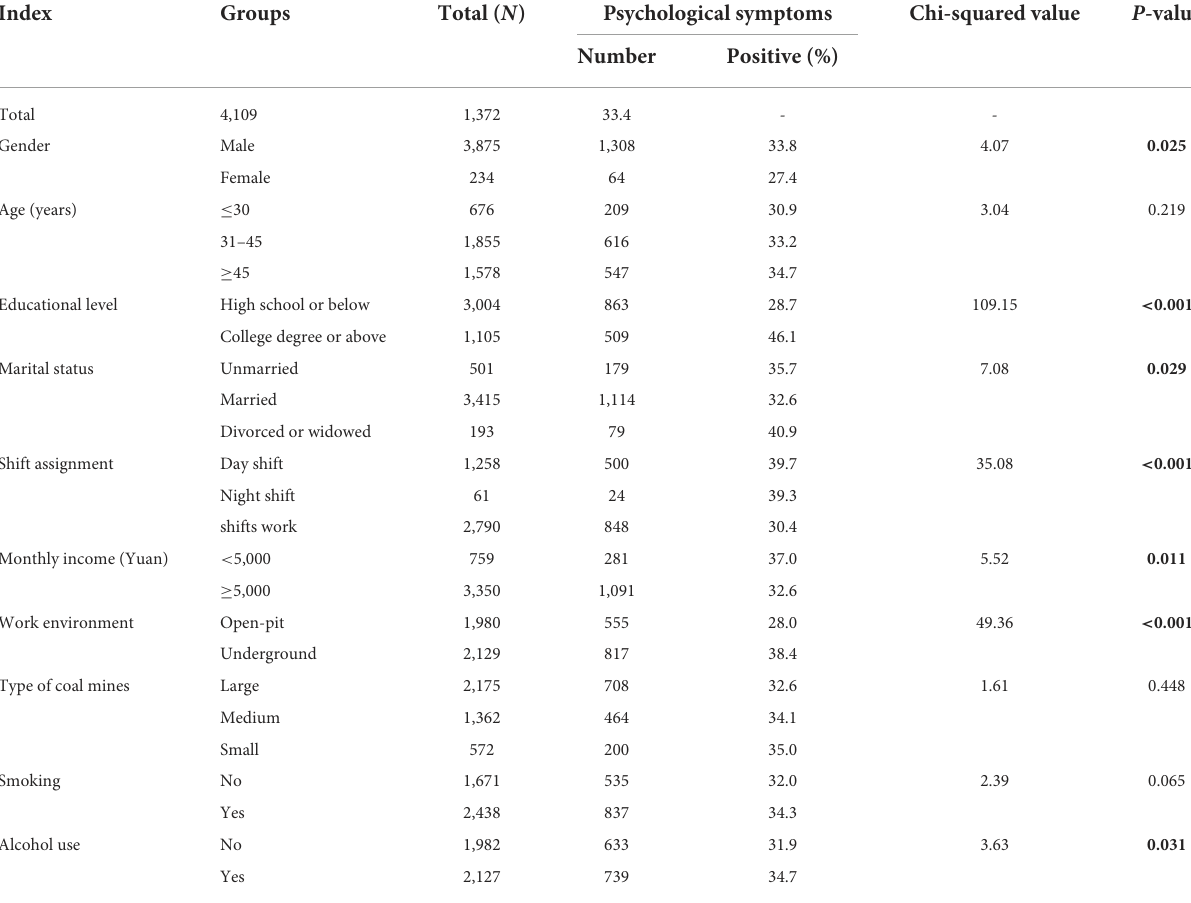
TABLE 1 The prevalence of psychological symptoms among different sub-groups ( N =